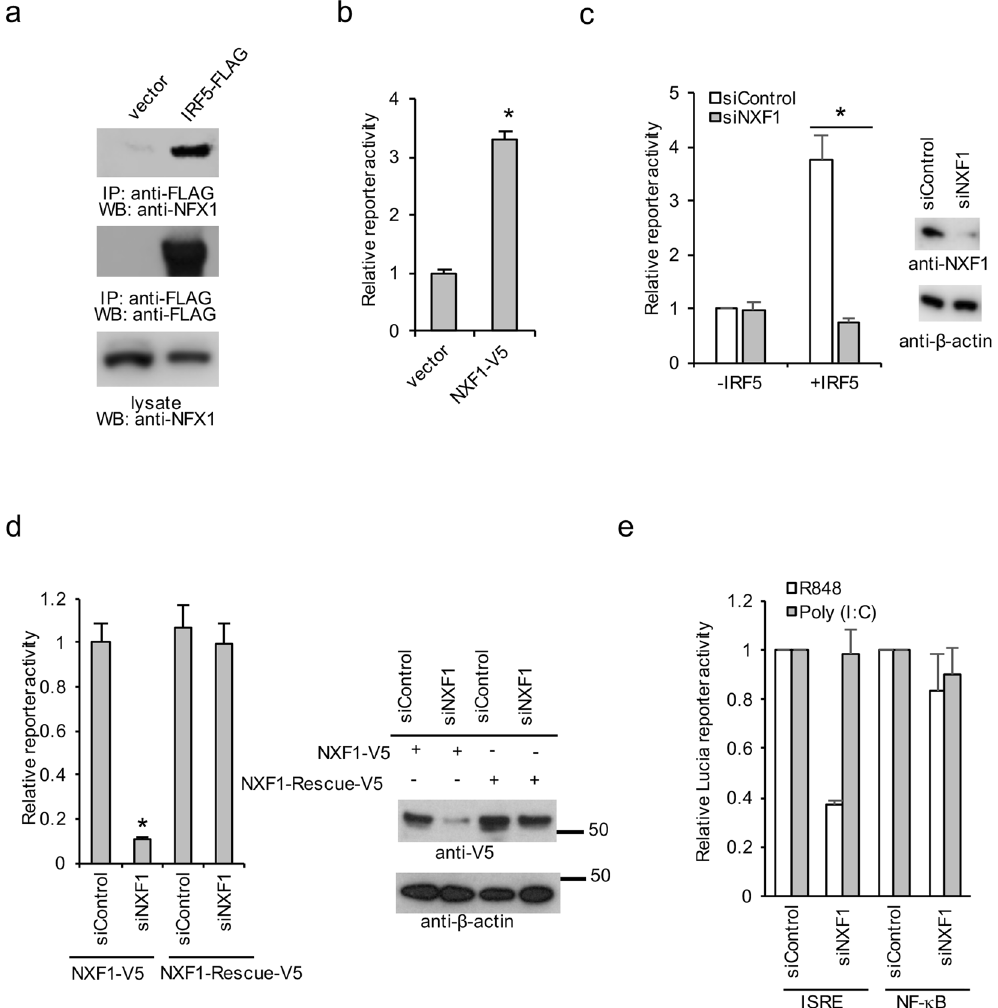
Figure 7. NXF1 regulates IRF5 pathway. ( a ) HEK293 cells were transfected with pCMV-3Tag-8 vector or IRF5- FLAG for 48 hr. Cell lysates were immunoprecipitated with anti-FLAG antibody and blotted with indicated antibodies. ( b ) NXF1-V5 or pCMV-3Tag8 vector was transfected into IRF5 reporter cells. After 48 hr, cells were stimulated with 10 μ g/ml R848 for 16 hr. Then cells were lysed and luciferase activities were examined. All experiments were repeated three times and two-tailed student t -test was performed. ( c ) HEK293/TLR7/Lucia cells expressing vector or IRF5 were transfected with control siRNA or NXF1 siRNA. After 72 hr, cells were stimulated with 10 μ g/ml R848 for 16 hr. Then cells were lysed and luciferase activities were examined. Western blot demonstrates the knockdown efficiency of endogenous NXF1. ( d ) IRF5 reporter cells were transfected with control siRNA or NXF1 siRNA together with wild type NXF1 or a rescue NXF1 cDNA which is resistant to the siRNA. The P value was calculated (two-tailed Student’s t -test) by comparison to the siRNA control. An asterisk indicates P < 0.05. Western blot demonstrates the knockdown efficiency. ( e ) THP-1 cells expressing a ISRE-luciferase and a NF- κ B reporter were transfected with control siRNA or NXF1 siRNA pairs. After 72 hr, cells were incubated with 10 μ g/ml R848 or 1 μ g/ml poly (I:C) for 16 hr. Cells were lysed and SEAP (NF- κ B) and luciferase (ISRE) activities were